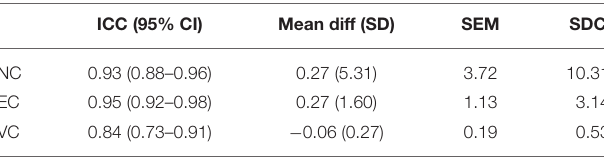
TABLE 2 | Reliability parameters of neural and non-neural components in patients with chronic stroke ( n =